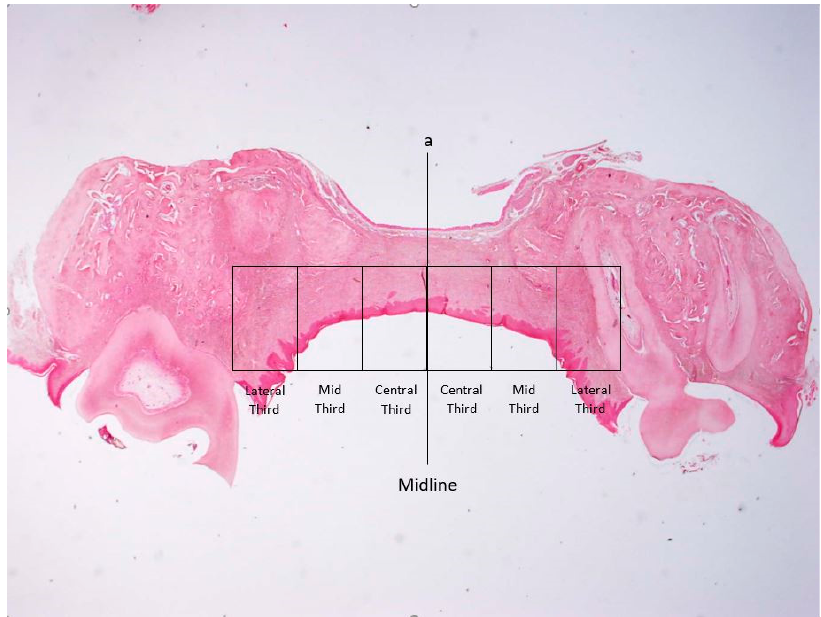
Figure 2. Illustration of the method used for establishing the palatal central, mid, and lateral thirds for the semi-quantitative assessment of the inflammation; a—the vertical line drawn at the midline of the palate (Hematoxylin and eosin stain, ×20 original magnification ) .